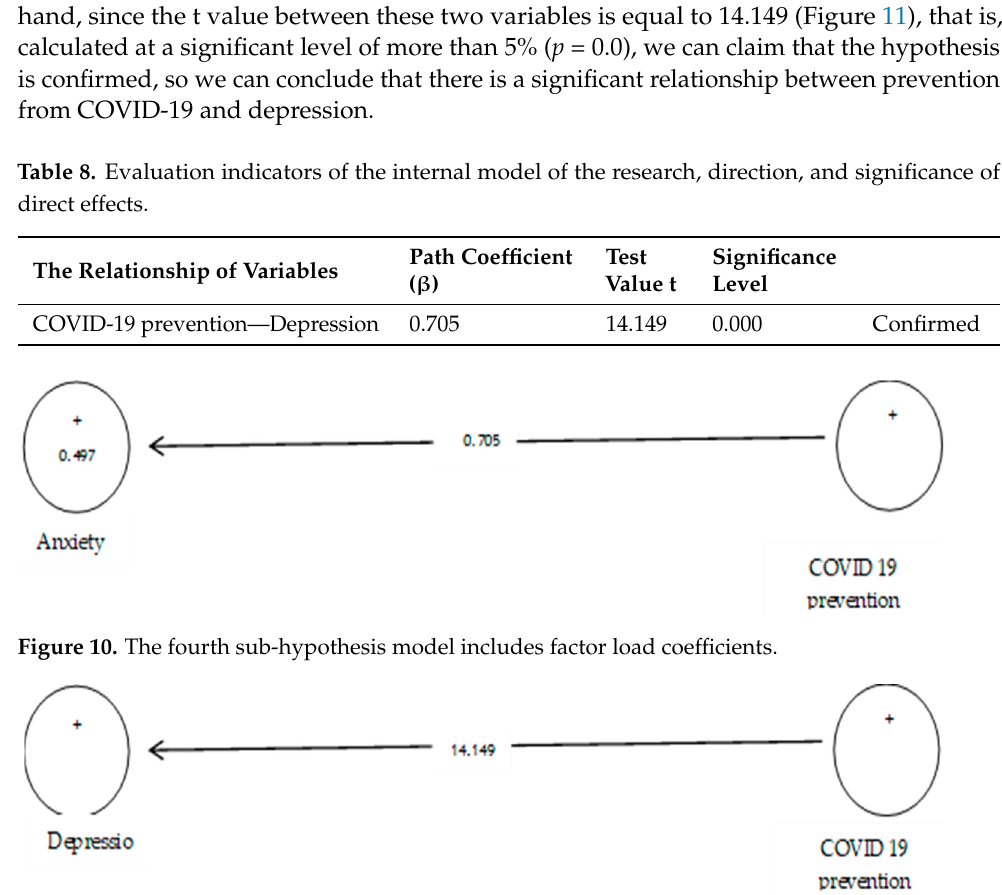
Figure 11. Drawn model with significant coefficients z. The variance-based structural equation modelling is used to assess the fifth